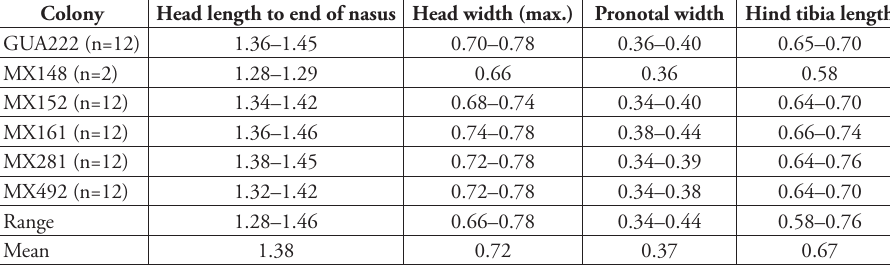
Table 5. Measurements (mm) of Parvitermes yucatanus sp. n. soldiers. Colony